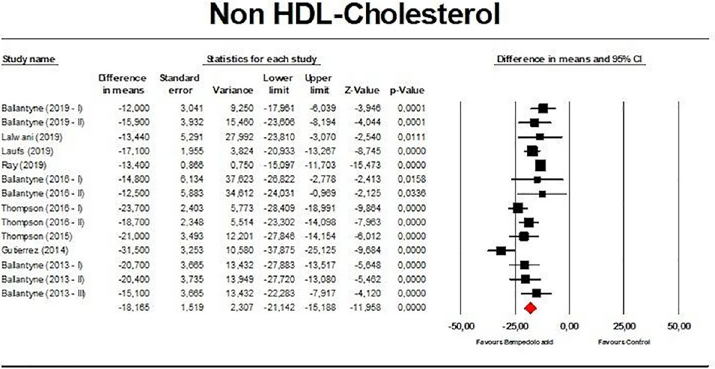
Fig 3. Forest plot displaying mean difference and 95% confidence intervals for the effect of bempedoic acid on plasma levels of non-high-density lipoprotein (HDL) cholesterol.